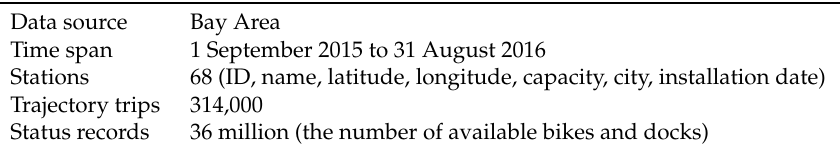
Table 2. Details of the